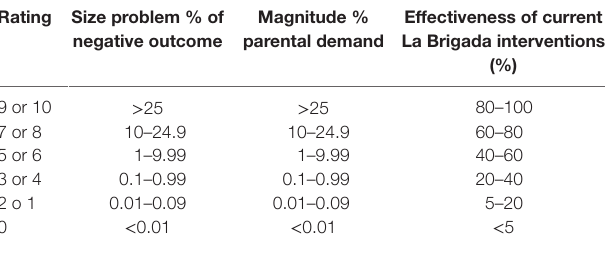
taBLe 1 | Criteria rating of the Hanlon